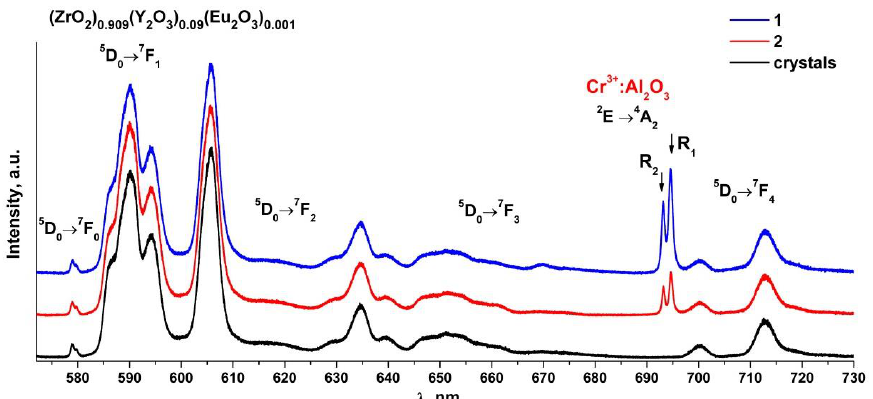
Figure 7. Luminescence spectra of (ZrO 2 ) 0.909 (Y 2 O 3 ) 0.09 (Eu 2 O 3 ) 0.001 single crystal and ceramic solid solutions synthesized using different methods from crushed single crystals: (1) uniaxial compaction; (2) slip casting. λ = 527 nm, Т = 300 K.